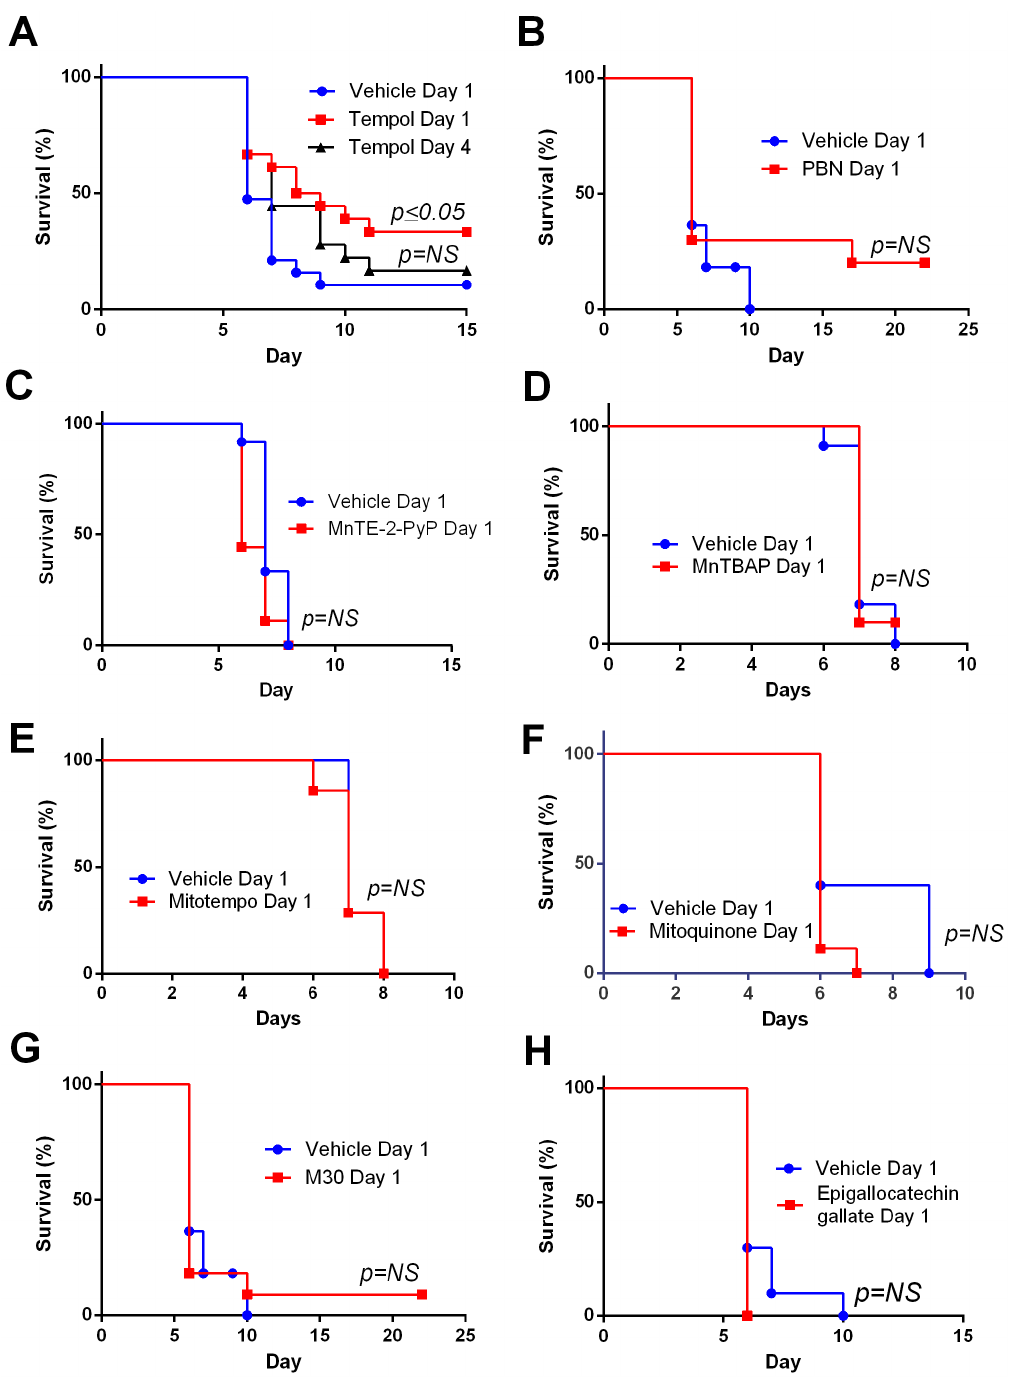
Figure 5. Tempol increases survival of mice in a cerebral malaria model. Comparison with other antioxidants. Plasmodium berghei Anka strain parasitized red blood cells (10 6 ) were injected in mice intraperitoneally (i.p.). Then, A, Tempol (20 mg/kg, n=40), B, PBN (50 mg/kg, n=10), C, MnTE-2-PyP (5 mg/kg, n=10), D , MnTBAP (10 mg/Kg, n=10), E , Mitotempo (3 mg/Kg, n=10), F , Mitoquinone (10 mg/Kg, n=10), G, M30 (7.5 mg/ kg, n=10), and H, Epigallocatechin gallate (25 mg/kg, n=10), were injected i.p. starting from day 1 (all reagents) or day 4 p.i. (for Tempol only) as indicated. One hundred m L of each antioxidant was injected i.p. daily/mice. The percent of non-treated and treated mice that survived over time is given in Kaplan–Meier curves. *, P # 0.05 (Log-rank test). NS,